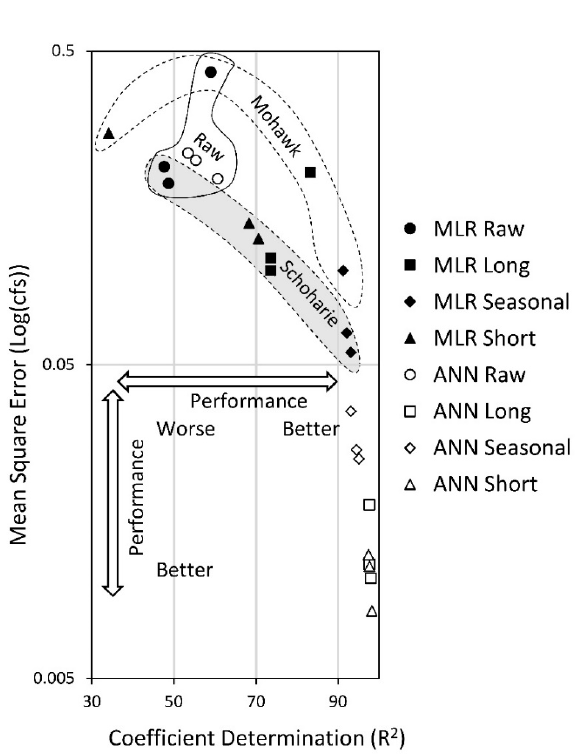
Figure 6. The MSE as a function of the coefficient determination (R 2 ) for the raw and the decomposed time series data using the MLR and the training ANN model.